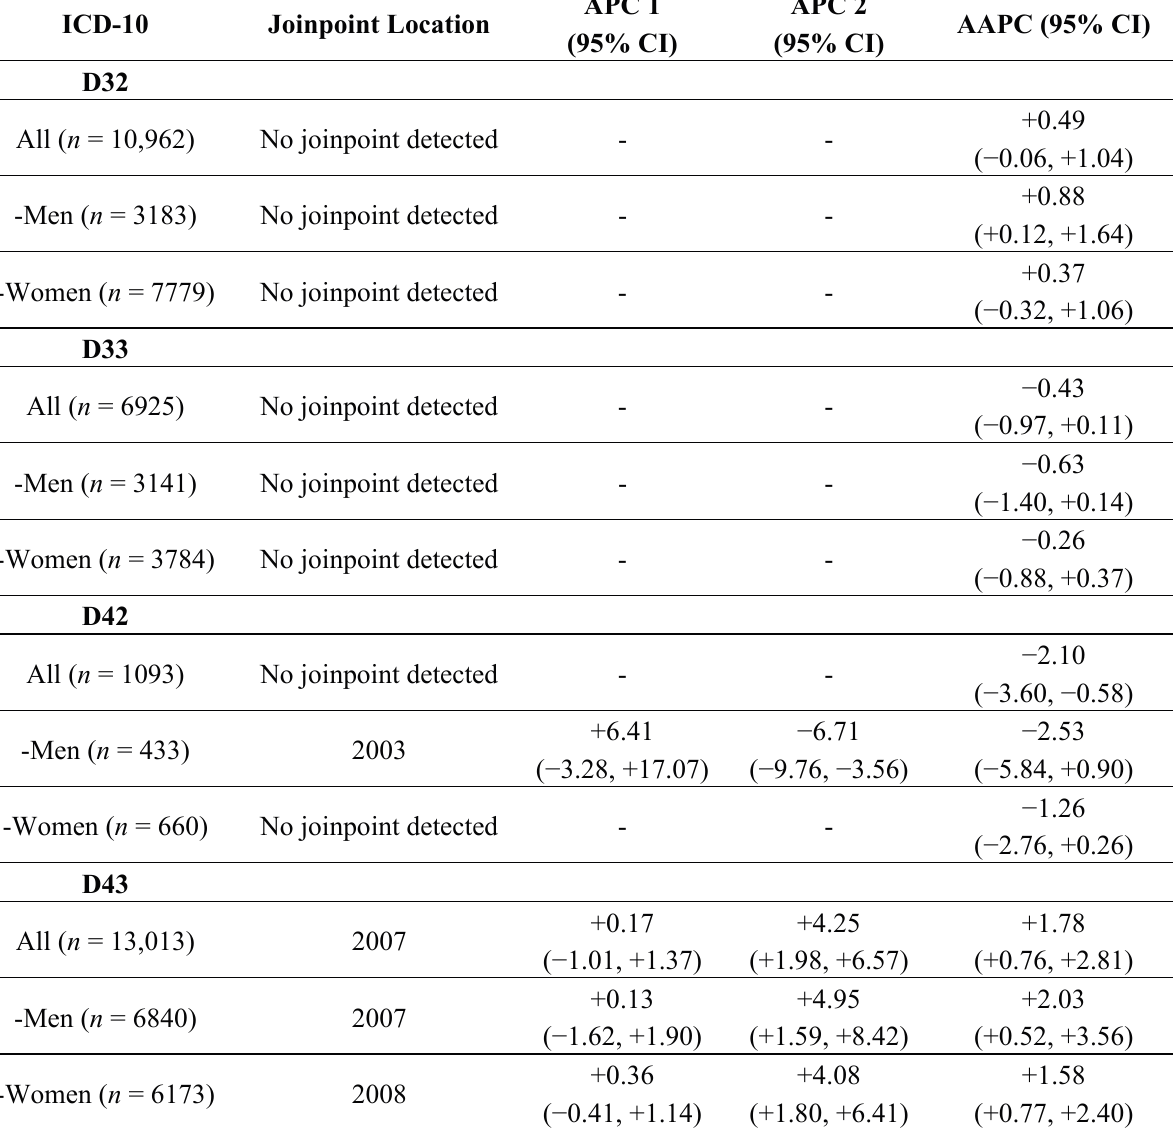
Table 1. Joinpoint regression analysis of trends in number of patients per 100,000 in the Swedish National Inpatient Register (IPR) 1998–2013